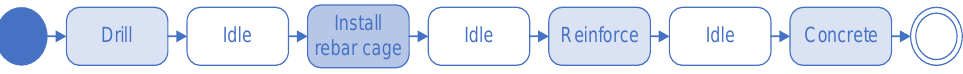
Figure 10. DES model (circles: Source/Sink; white: LoD1; light blue: LoD2; and blue: LoD3).